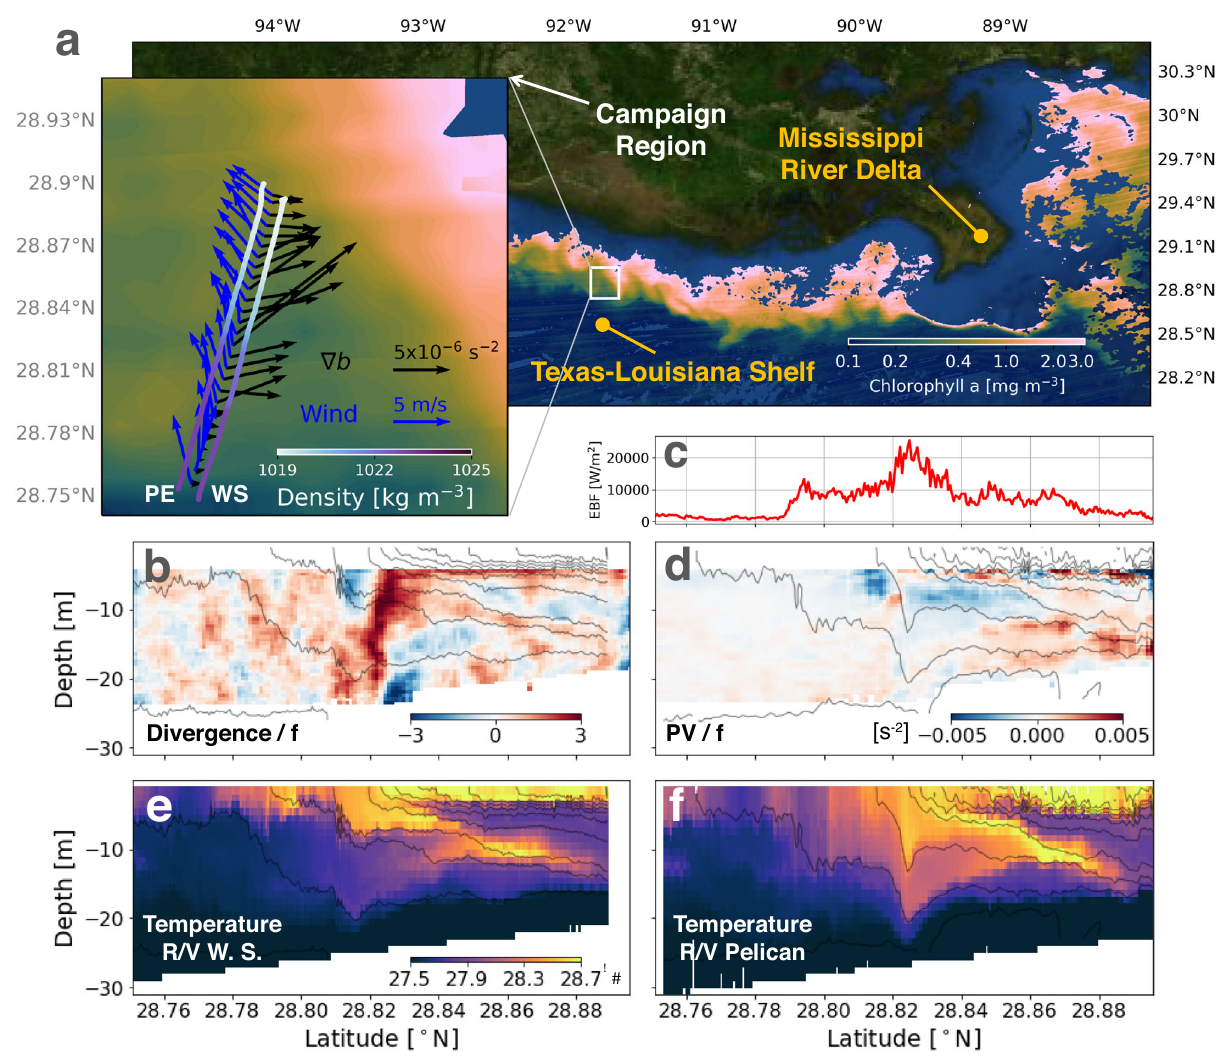
Fig.2|SUNRISECampaign2021.a Satelliteimageryofsurfacechlorophyllaover theTexas-Louisiana shelffromNASASuomiNPPVIIRSOceanColor.Theimagery is composited using the data collected between 18:00 and 20:00 UTC June 24, 2021. The subpanel is a zoomed in view of a region of the SUNRISE fi eld cam- paign, where repeated (every 4h), parallel transects were made by R/Vs Pelican (PE) and Walton Smith (WS) to sample the fronts in the Mississippi/Atchafalaya river plume. The two transects (roughly 17km long each) were made between 03:00 and07:00UTC June 24, 2021to sample the frontwhich ischaracterizedin the satellite imageryby strong gradients of chlorophyll. The front near-inertially oscillated by entering the sampling region and retreating. The ship tracks are